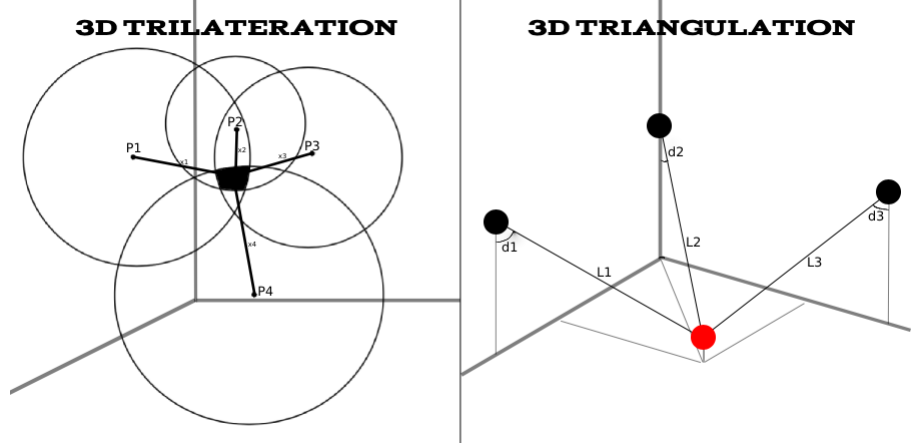
Figure 2. 3D Trilateration and 3D